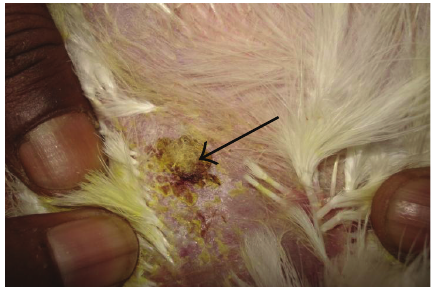
Figure 8: DTH reaction of skin (T-2 toxin plus SBT 400 ppm plus GM): severe increase in skin thickness, ulceration, induration, and scab formation compare to toxin-fed bird.